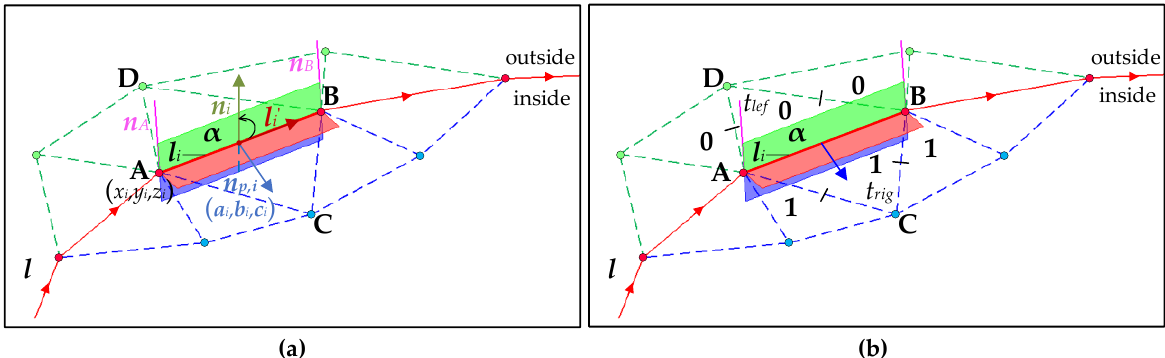
Figure 8. Judgment and marking method for the inside and outside triangular patches of the model boundary. ( a ) shows the judgment method of the inside and outside triangular patches of the model boundary, the blue patch is on the inside of the boundary, and the green patch is on the outside of the boundary. ( b ) shows the marking method for the inside and outside triangular patches of the model boundary.